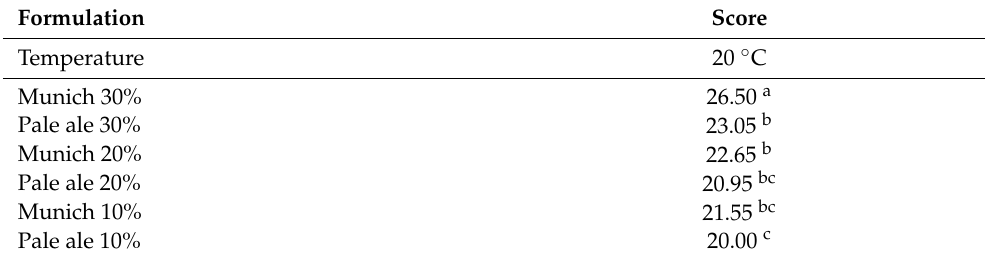
Table 1. Table presenting evaluating scores/acceptance of formulated beverages. Formulation